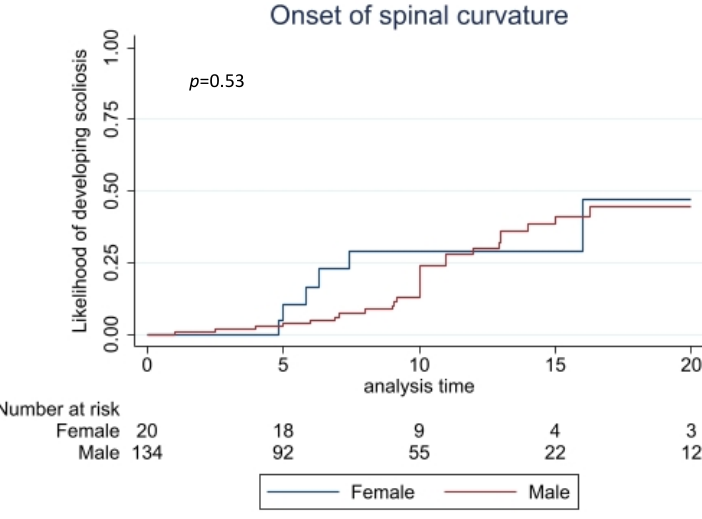
Figure 5. Time-to-event estimates of developing scoliosis.